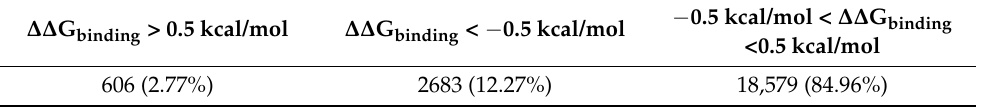
Table 2. Mutation distribution in relation to ∆∆ G binding .